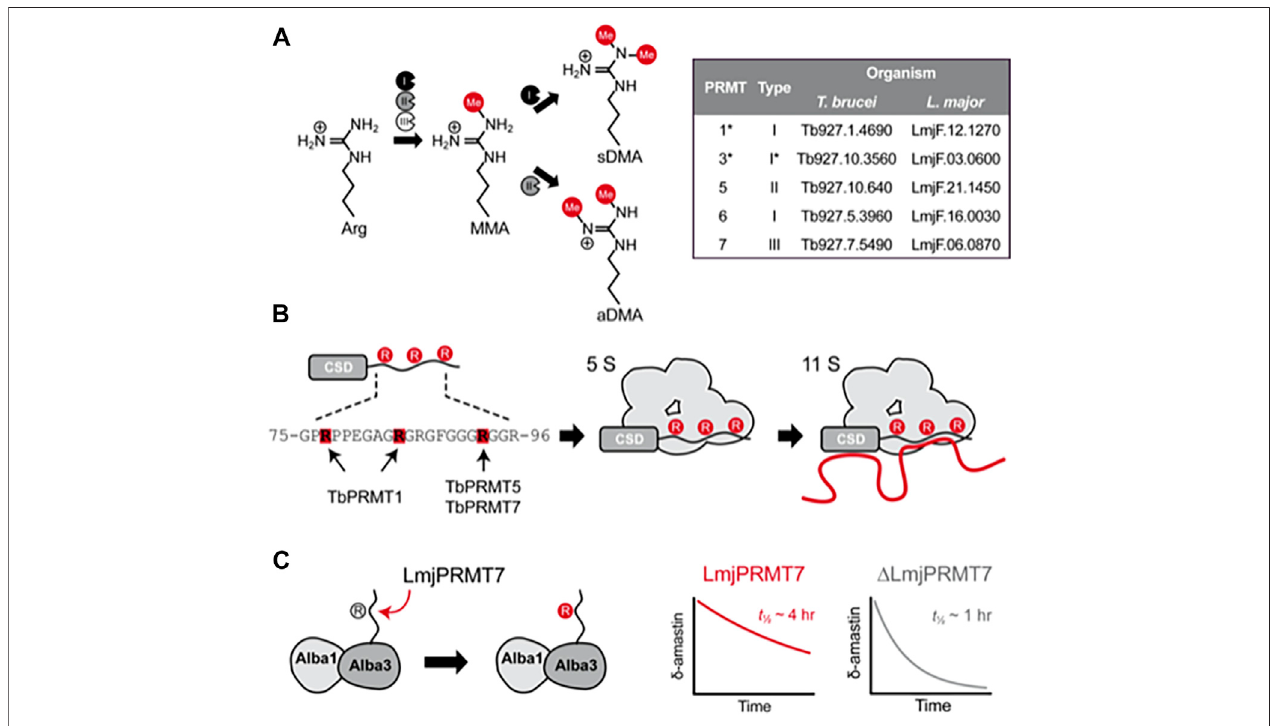
FIGURE 1 | Molecular effects of arginine methylation in T. brucei and L. major . (A) , Protein arginine methyltranferases (PRMTs) from types I, II and III are able to generatemonomethylarginine(MMA)bytransferingthemethylgroupfromS-adenosylmethioninetotheterminalnitrogenatomofarginineresidues.WhiletypeIIIPRMTs only produce monomethylated products, type I PRMTs catalyze a second round of methylation at the same atom, generating asymmetrically dimethylated arginine (aDMA), whereas type II PRMTs add another methyl group to the adjacent terminal nitrogen, forming symmetric dimethylarginine (sDMA). The inset table contains the gene IDs of PRMT genes found in the genome of T. brucei and L. major . (B) , Schematic representation of how methylation affects the capability of RBP16 to form macromolecular complexes containing proteins (gray) and RNA (red line) in T. brucei . The RBP16 intrinsically disordered RGG domain is methylated by Tb PRMT1 on Arg78 and Arg85, whereas Arg93 is (potentially) methylated by either or both Tb PRMT5 and Tb PRMT7 (left) . In its methylated state, RBP16 can associate with other proteins (5S complex) or with proteins and RNA (11S complex). A non-methylatable version of RBP16 is still able to associate with RNA but loses the capability to form multiprotein complexes. Non-methylated arginines are represented by gray circles and methylated arginines by red circles. (C) , Representation of the methylation mediatedby L.major PRMT7onAlba3.Alba3interactswithAlba1and δ -amastintranscripts.MethylatedAlba3hasastrongerassociationwith δ -amastintranscriptsand protects the RNA from degradation. The ability of Alba3 to bind δ -amastin is reduced upon Lmj PRMT7-knockout, which reduces the half-life of the transcripts from approximately 4 h to around 1 h. *PRMT3 is currently known as PRMT1 PRO in T. brucei ; despite its similarity to mammalian PRMT3, Tb PRMT3 misses key residues for PRMT activity, and is rather a prozyme for the catalytic Tb PRMT1, which was thus renamed to Tb PRMT1 ENZ